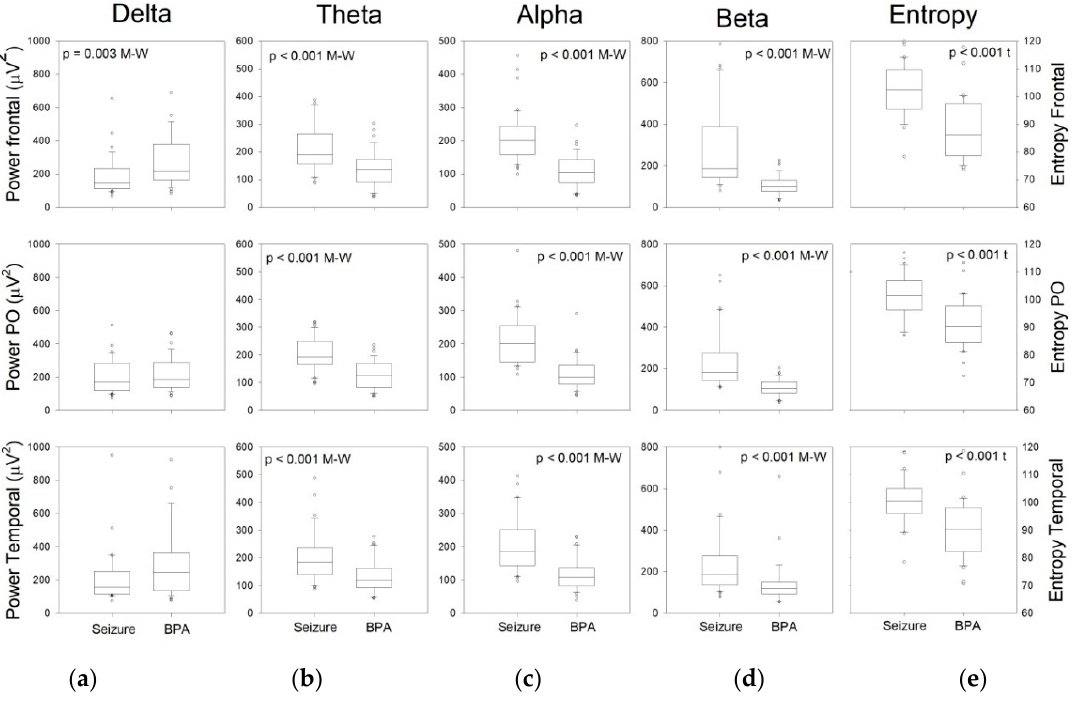
Figure 5. Comparison by bands and lobes between ES and BPA. ( a ) Delta; ( b ) Theta; ( c ) Alpha; ( d ) Beta; (e) Entropy. Probability is indicated when difference between ES and BPA is significant. M–W =